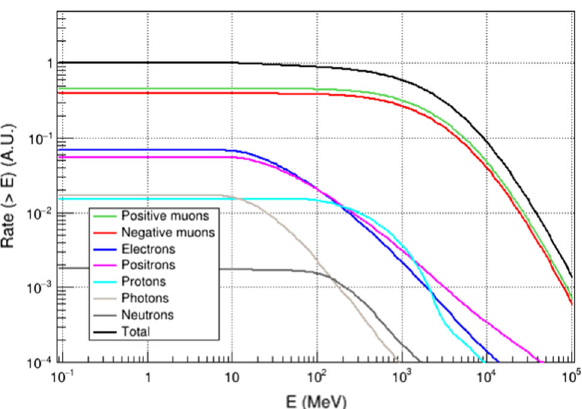
Fig. 8 Expected integrated rate as a function of the minimum energy of secondary cosmic rays, for a point at sea level at (45 ◦ N 15 ◦ E) Earth Position, on August 1, 2018. For each kind of particle, the rate is normalised to the total rate (black line) at the lowest energy value. The coloured lines show the rates normalised in this way for different